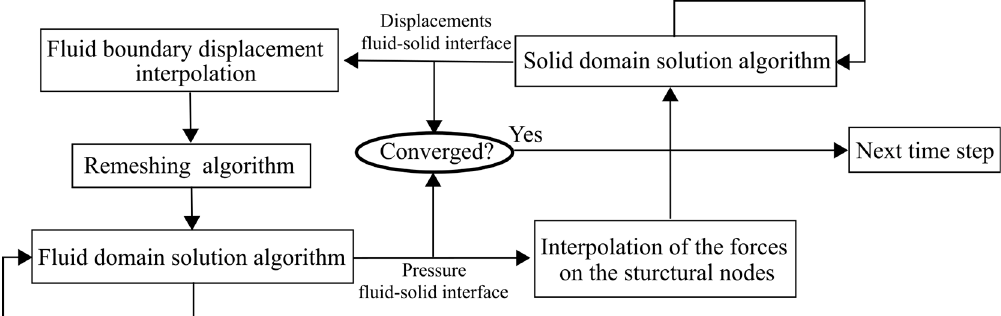
Figure 6. Fluid–structure interaction model stagger loop solution procedure.